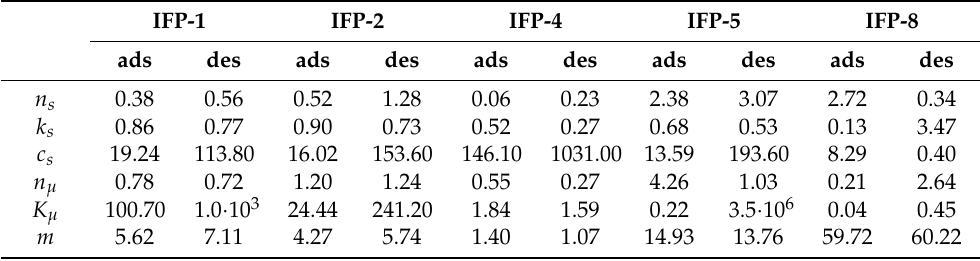
Table A2. Numerical parameters for the equilibrium model applied for the adsorption and